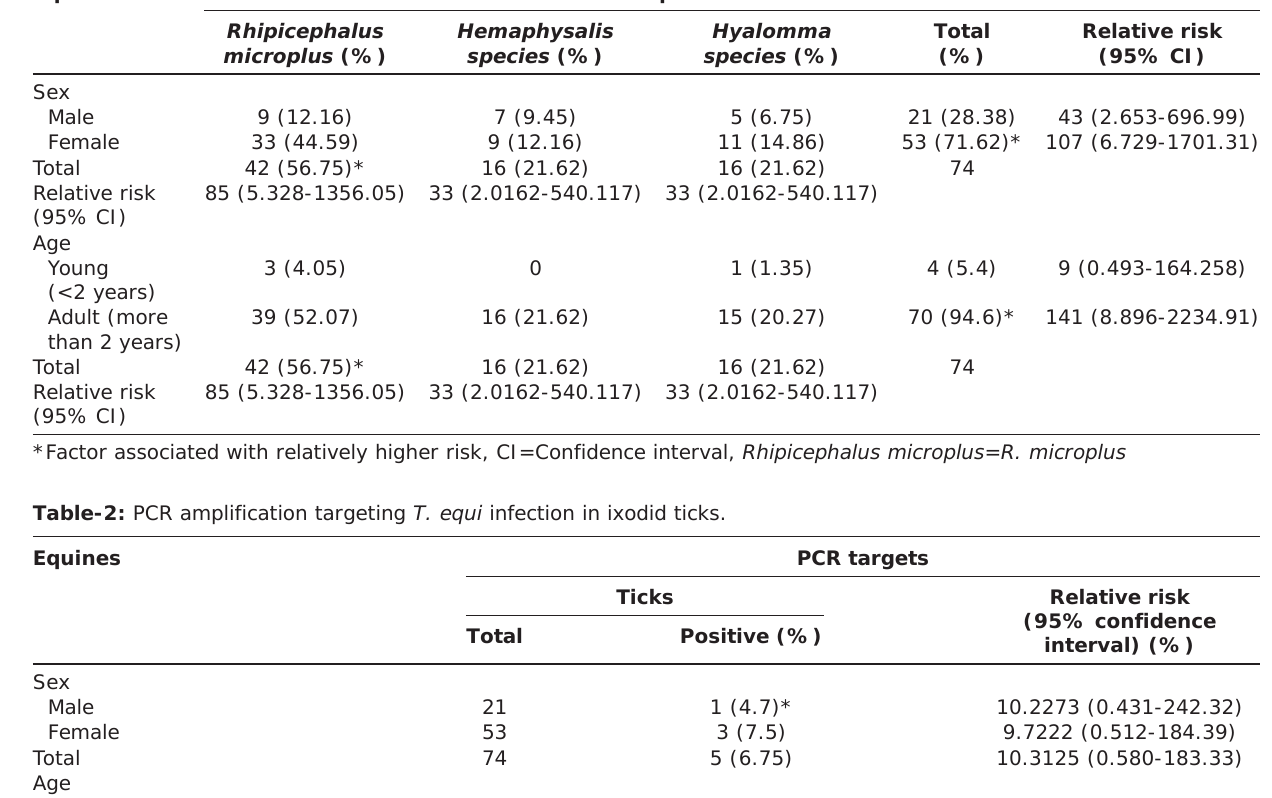
Table-1: Prevalence of ticks targeting age and sex of equines. Equines Species of ticks